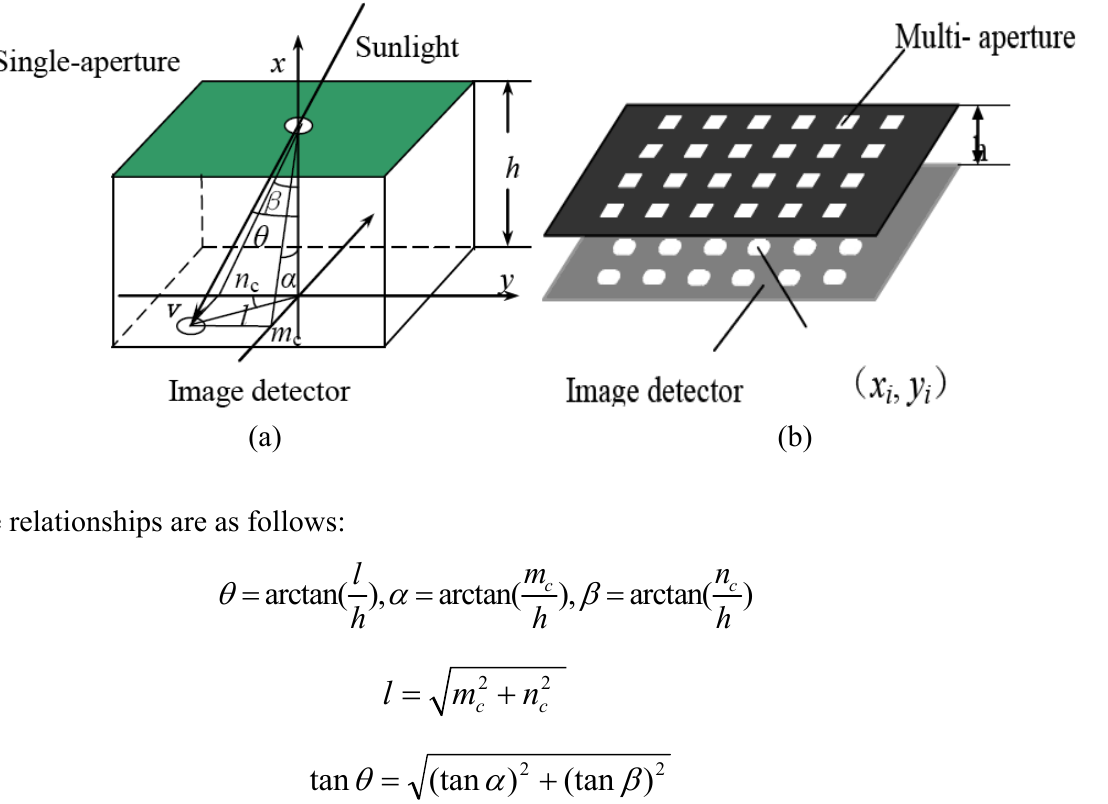
Figure 1. (a) single-aperture sun sensor (b) multi-aperture sun